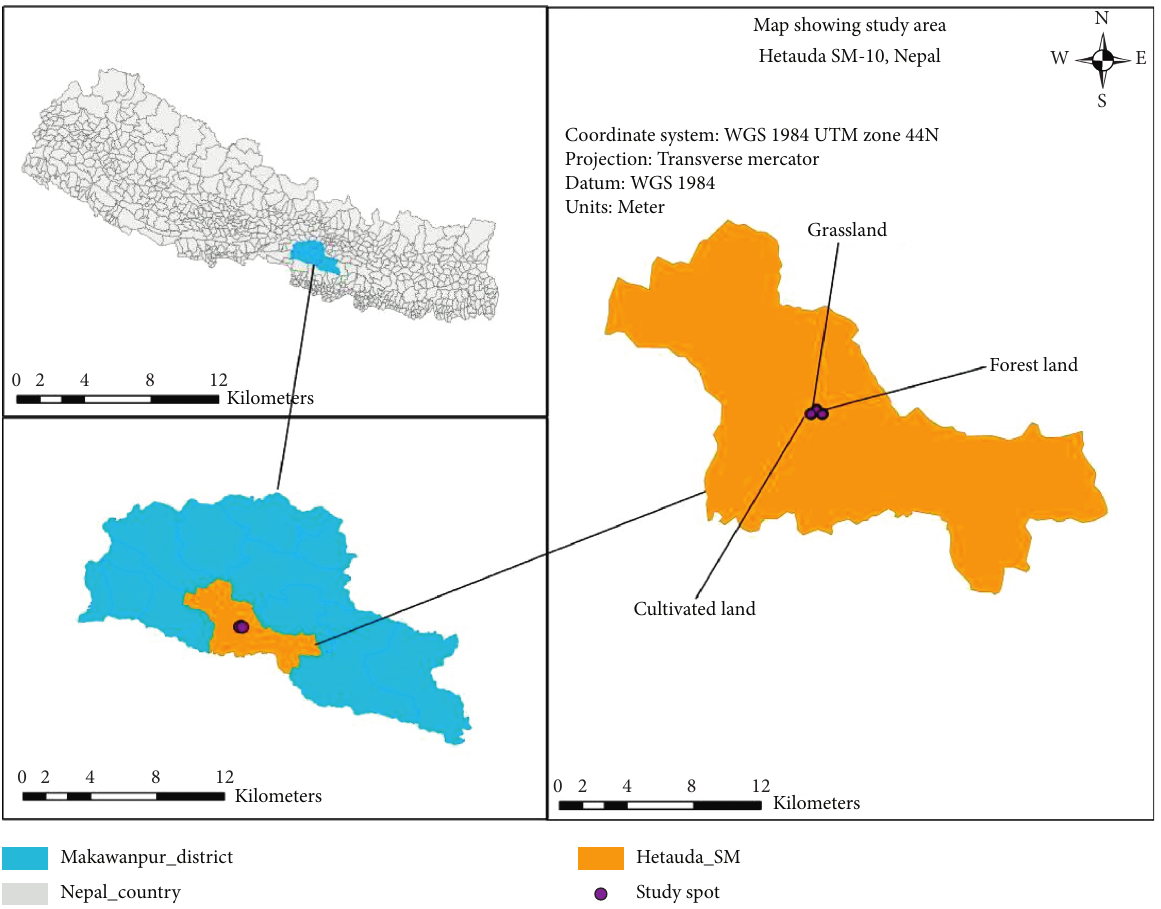
Figure 1: Map showing research